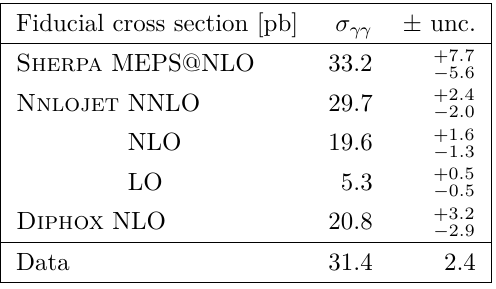
Table 5. Integrated fiducial cross section from ATLAS data compared with theory predictions with their systematic uncertainties from QCD scale